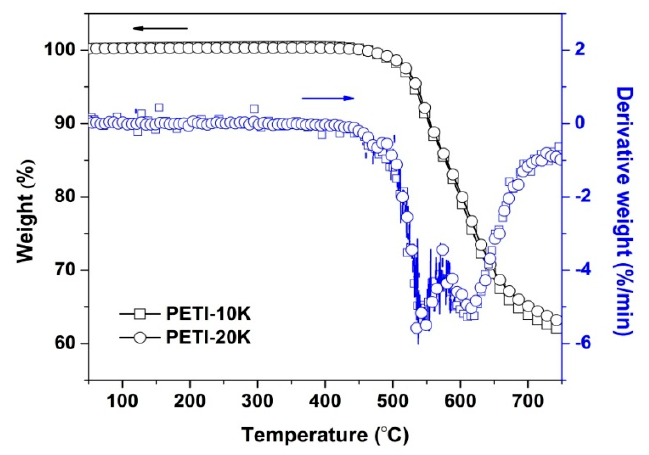
Figure 7. TGA and DTA plots of the electrospun PI nano ‐ fibrous membranes in nitrogen. Figure 8 depicts the glass transition behaviors of the PI NFMs recorded by DSC. All were all higher than 270.0 °C. This was mainly due to the bulky phthalide units in the